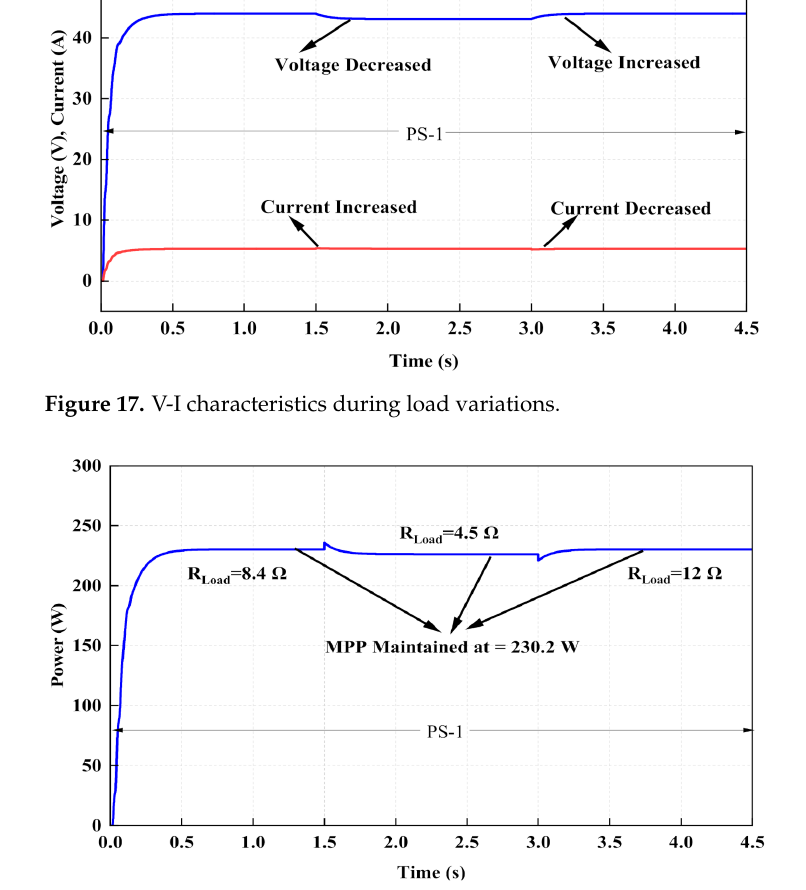
Figure 18. Power characteristics during load